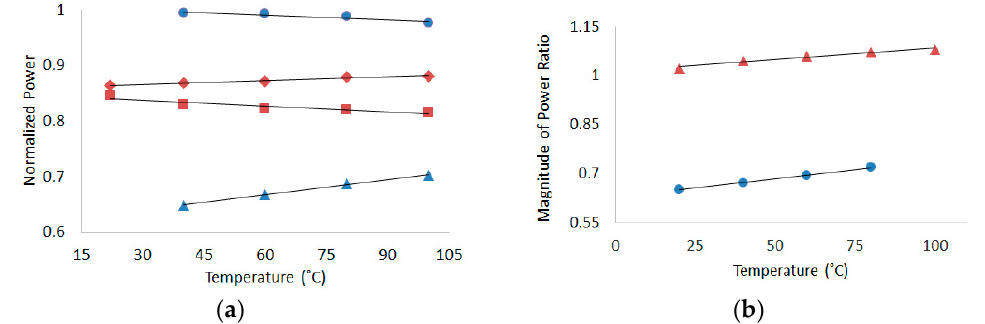
Figure 6. ( a ) Variation in normalized RF power as a function of temperature for Sensor 1 at frequencies of 7.24 GHz ( (cid:4) ) and 7.48 GHz ( (cid:7) ) and for Sensor 2 at frequencies of 15.38 GHz ( (cid:78) ) and 15.1 GHz ( • ). ( b ) Ratiometric measurement for Sensor 1 ( (cid:78) , magnitude of the ratio of power at 7.48 GHz to 7.24 GHz) and for Sensor 2 ( • ), magnitude of the ratio of power at 15.38 GHz to 15.1 GHz) (after Reference [12]).